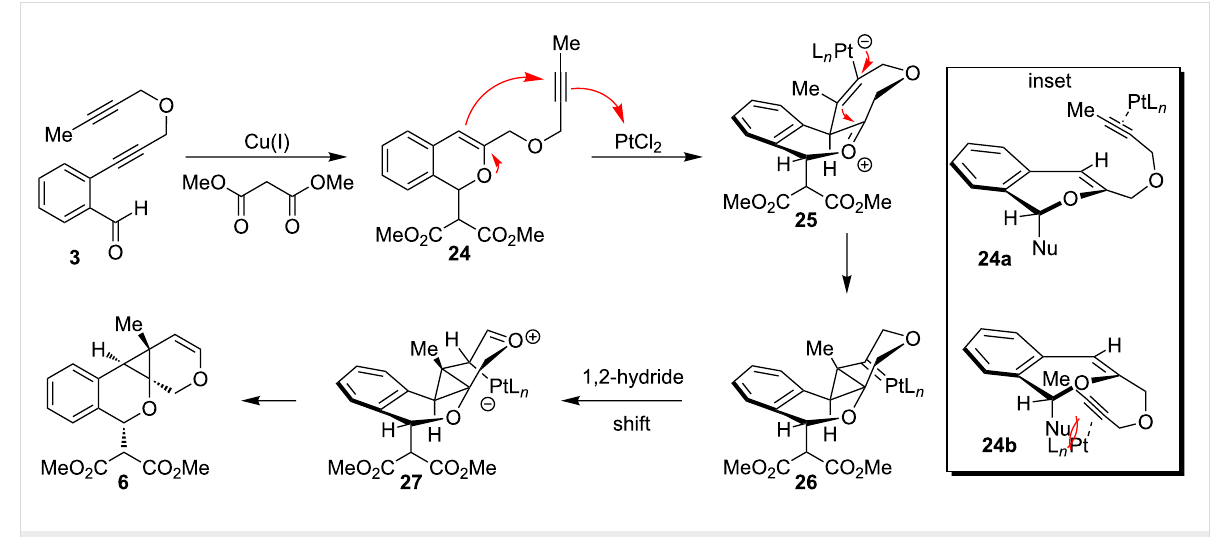
Scheme 3: Proposed reaction pathway for diastereoselective, sequential cycloisomerization.